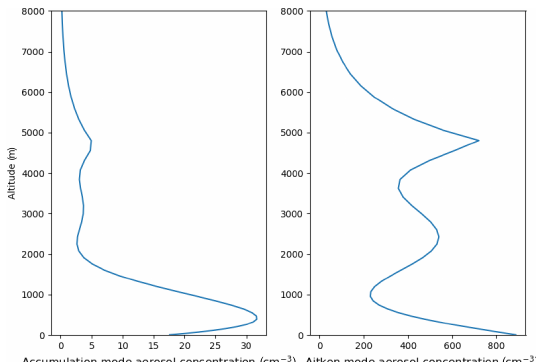
Figure 1. Vertical profiles of accumulation and Aitken mode aerosol concentration used in the baseline